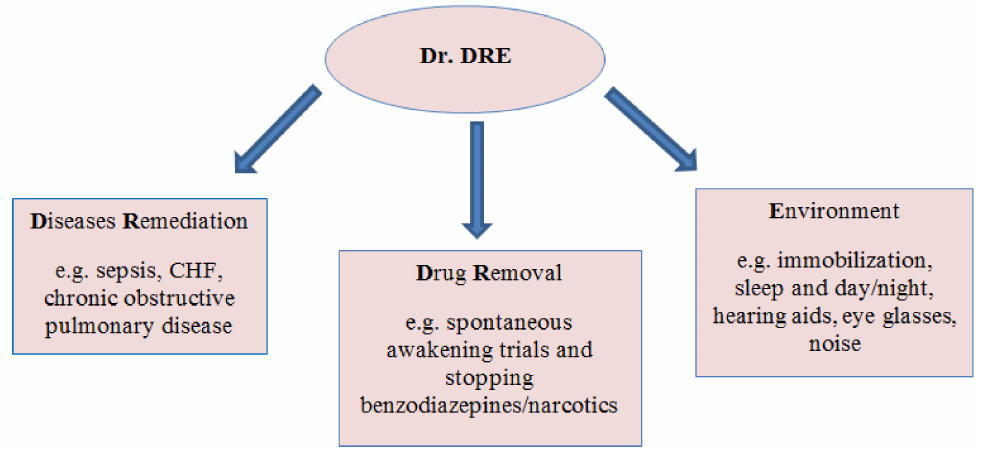
Figure 4. Simple mnemonic called “Dr. DRE”